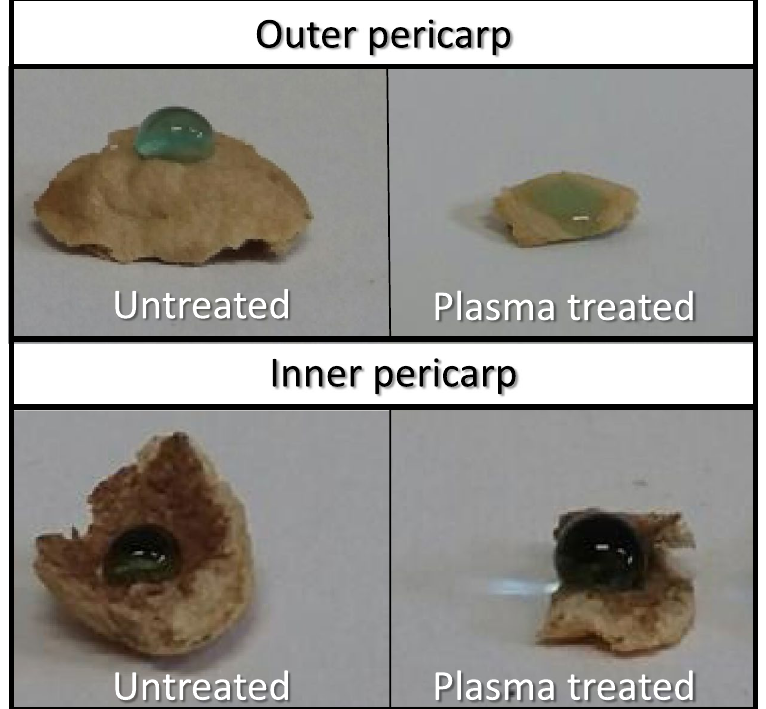
Figure 3. Water apparent contact angle of untreated and plasma treated (30 s) nasturtium seeds in the outer and inner part of the pericarp. A very diluted methylene blue concentration was used in order to better appreciate the water